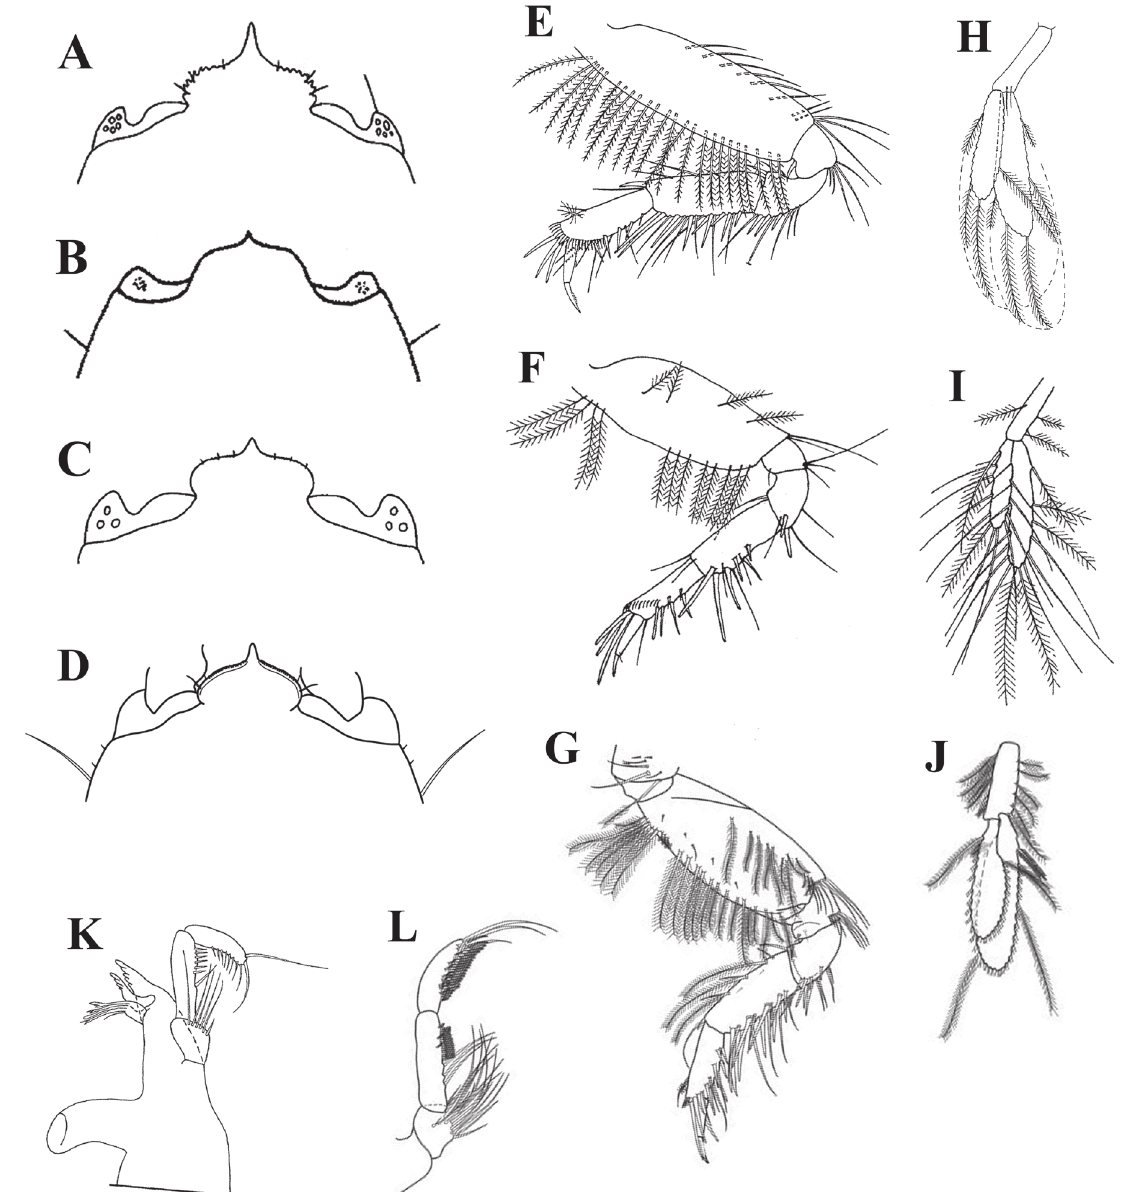
Figure 14. Tip of rostrum: A Brachylicoa estasiatica ; B B. indonesiana ; C B. muelleri ; D B. lui sp. n. Pereopod-6: E B. indonesiana ; F B. muelleri ; G B. lui sp. n. Pleopod: H B. indonesiana ; I B . muelleri ; J B. lui sp. n. Mandible palp: K B. muelleri ; L B. lui sp. n. Figures modified from [Băcescu 1978 ( A ); Guţu 2007 ( B , E , H) ; Guţu 2006 ( C , F , I , K ); and this study ( D , G , J , L ]; not to